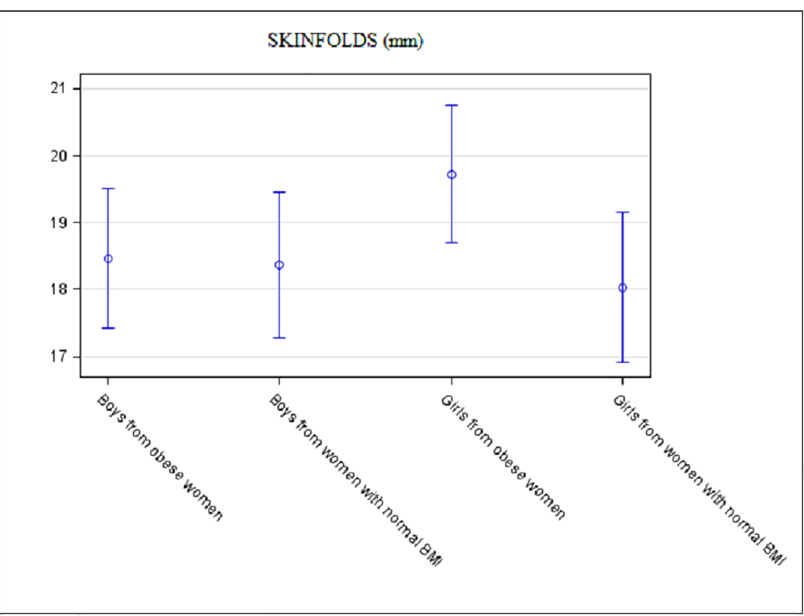
Fig 2. Adjusted neonatal sum of skinfolds according to maternal BMI and according to the sex of the neonate. Data are mean with 95% confidencelimits.